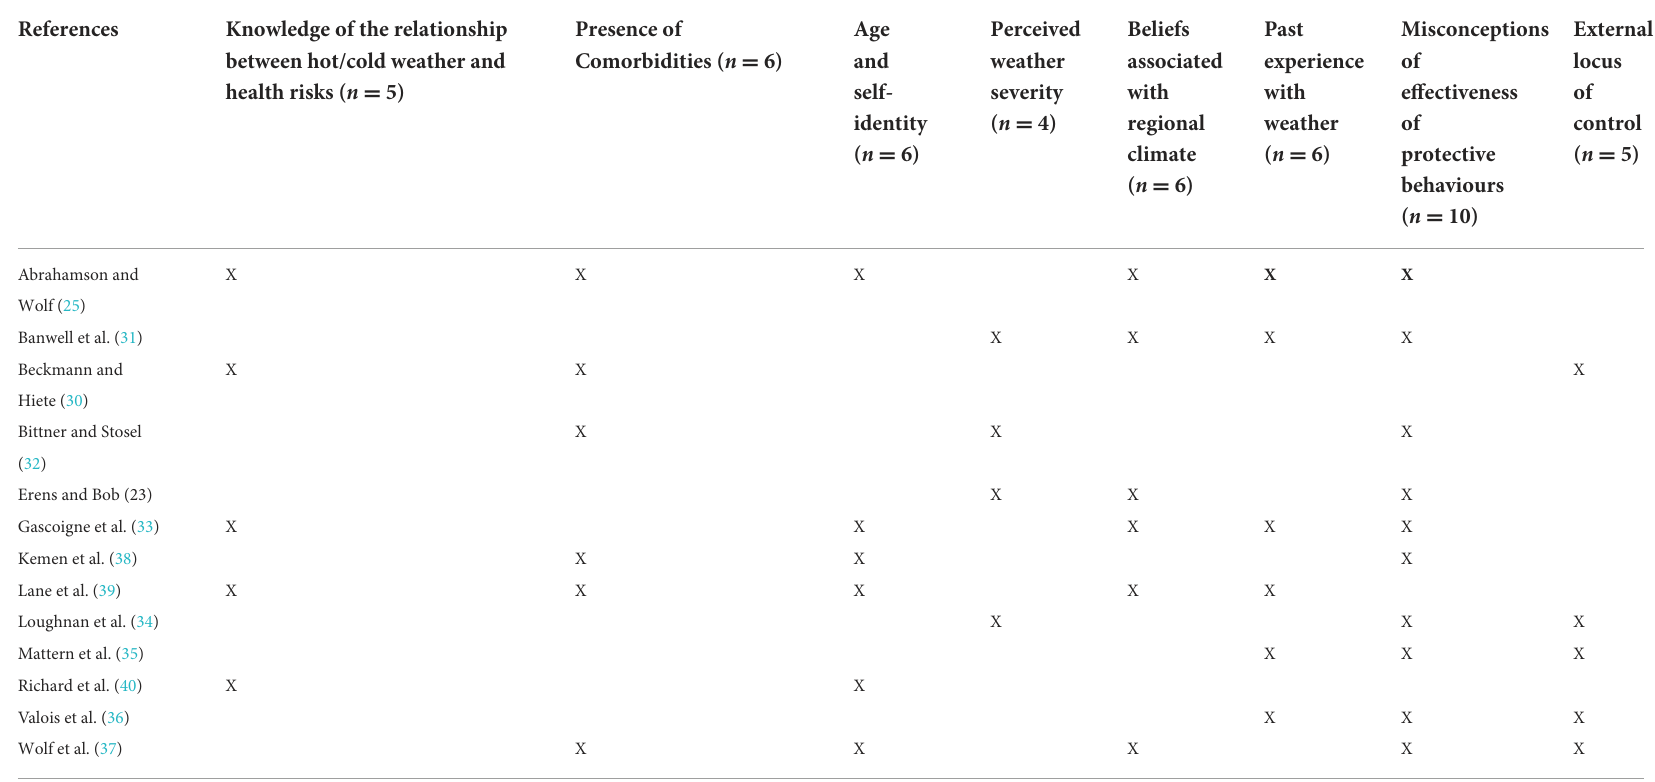
TABLE 3 Presence of identified factors influencing risk perception in older adults across included